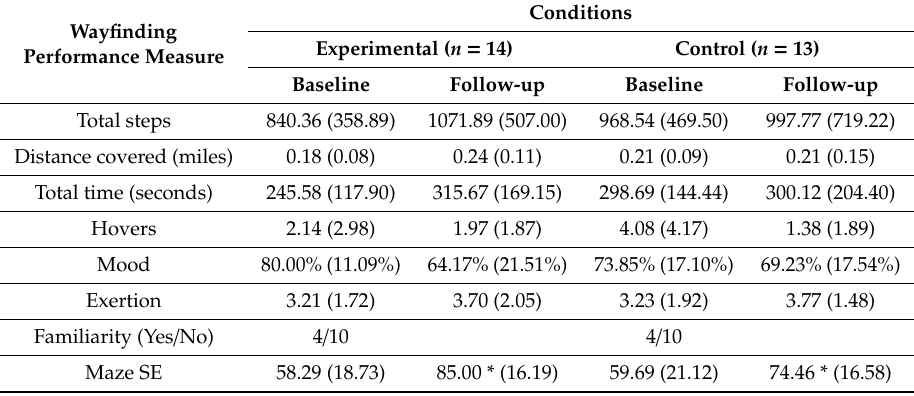
Table 2. Wayfinding performance and self-e ffi cacy means (SD) between